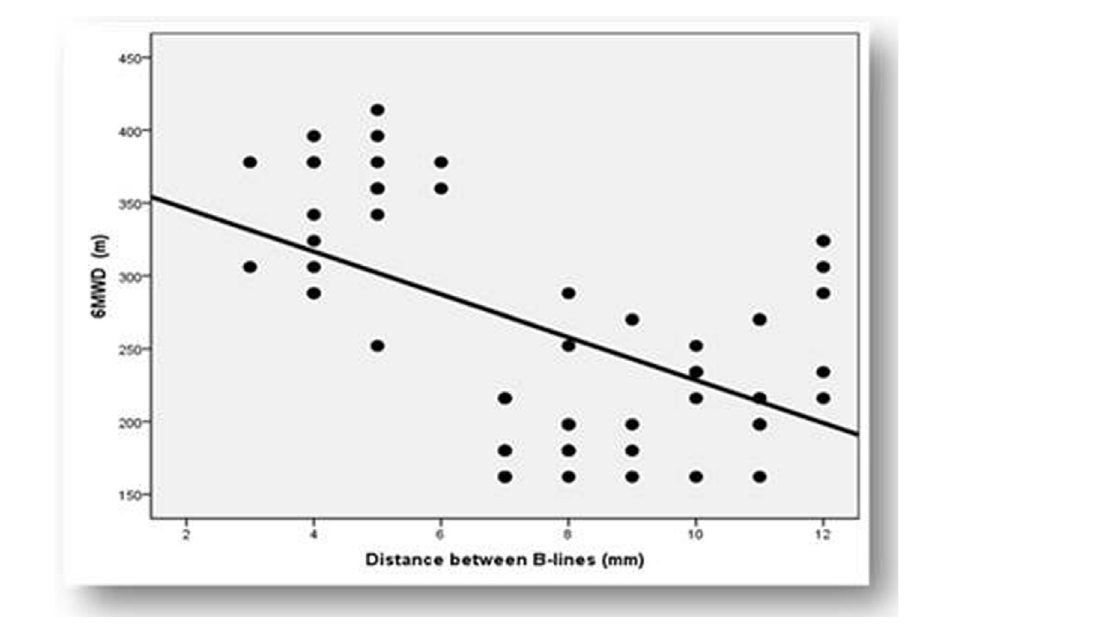
The relation between B-line distance and 6-minute walk test (6MWT).